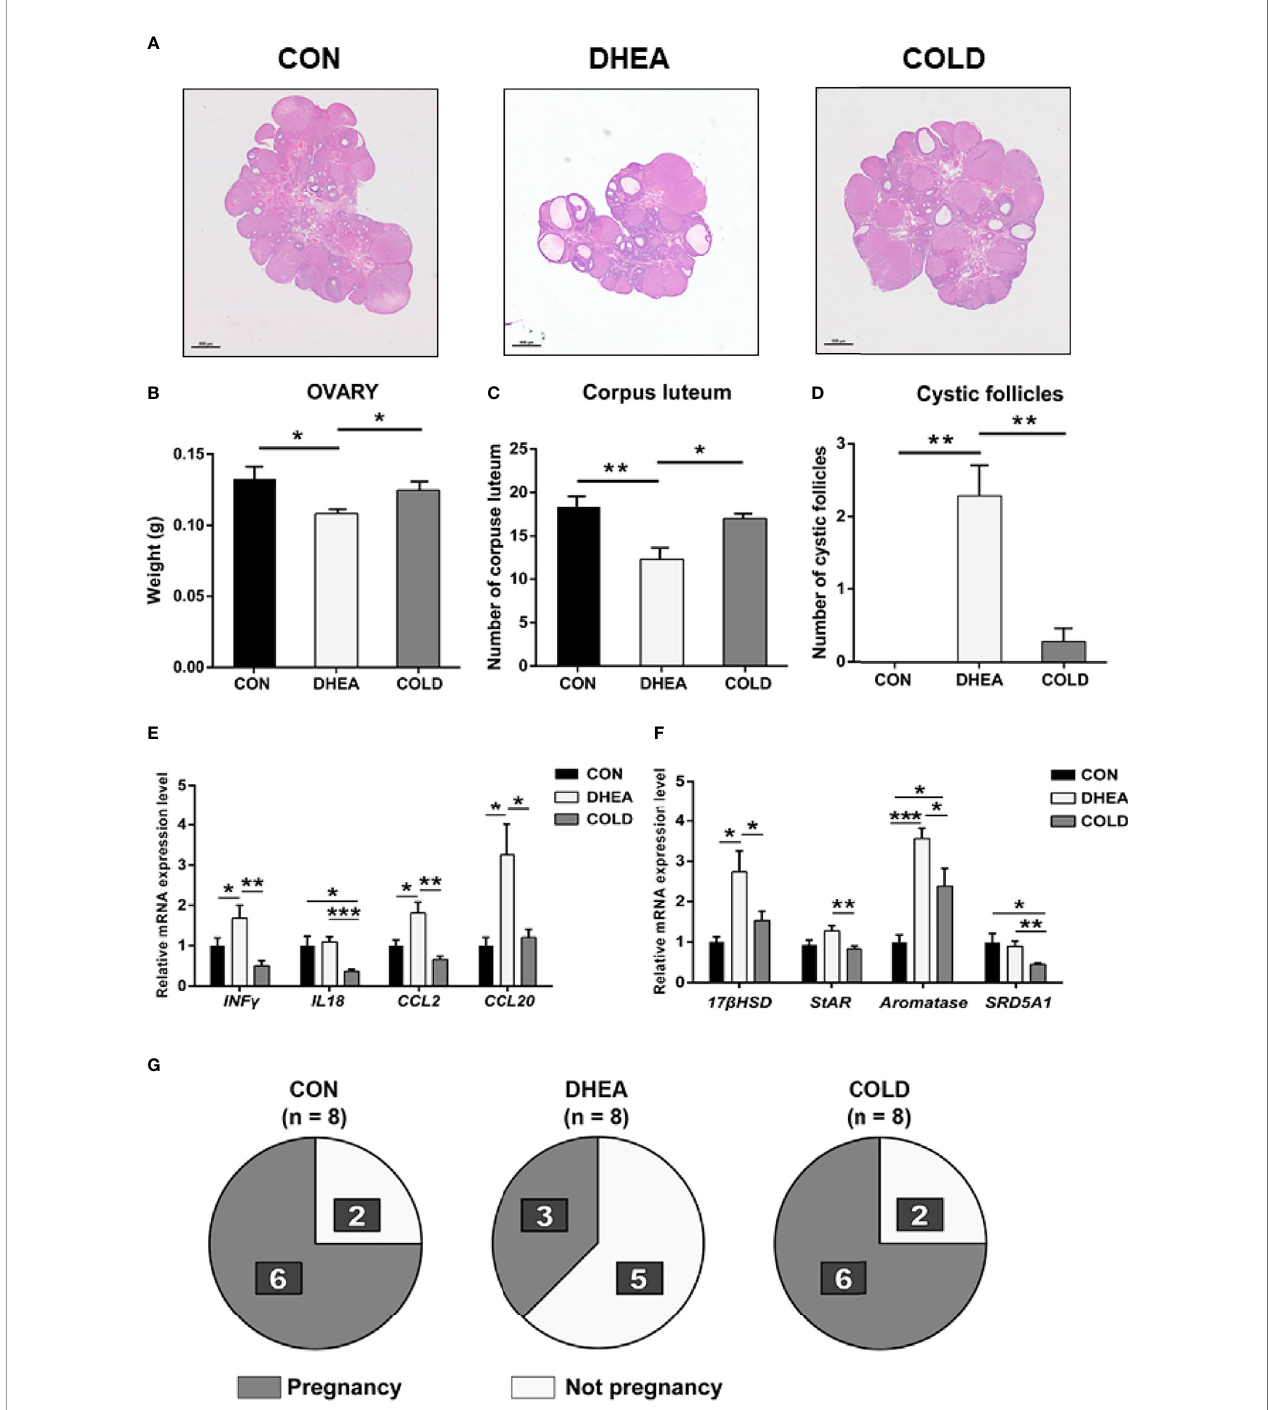
FIGURE 3 | Cold treatment improved ovary dysfunction and normalized fertility in PCOS rat. (A) Hematoxylin and eosin staining of representative ovaries. Scale bar: 800 m m. (B) The weight of ovary. (C) The number of corpus luteum. (D) The number of cystic follicles. (E) The mRNA level of in fl ammation-related genes in ovary. (F) The mRNA level of ovarian steroidogenic enzymes. (G) The number of pregnancy rats and not pregnancy rats are shown in dark and bright. Data are means ± SEM. (A, C, D) CON and DHEA treatment (n = 8/group), and Cold treatment (n = 10/group); (B, E, F) Con and DHEA treatment (n = 10/group), and Cold treatment (n = 10/group). (G) CON, DHEA treatment and COLD treatment (n= 8/group). One-way ANOVA with Tukey post-hoc test was used to compare groups. * P < 0.05, ** P < 0.01, *** P <